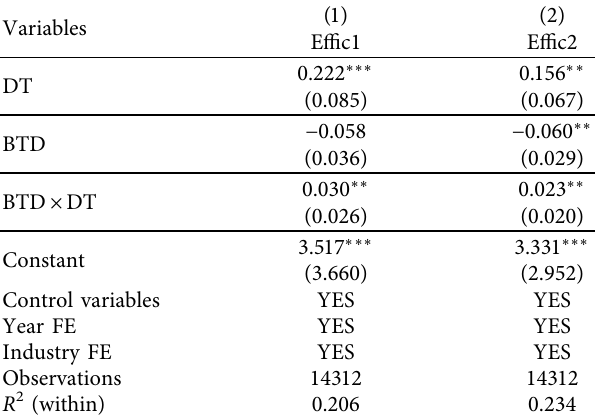
Table 9: Digital transformation, corporate tax avoidance, and corporate investment